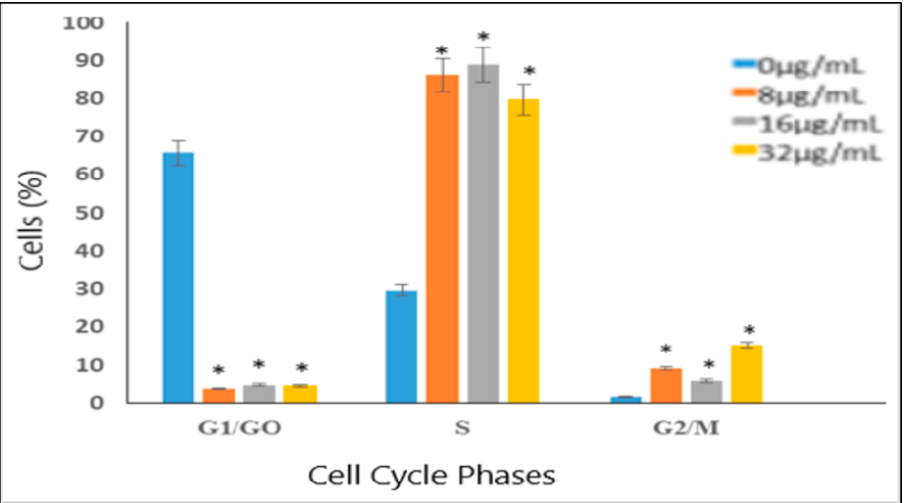
Figure 8. Bar graph showing percentage (%) of OVCAR-3 cells in different phases of the cell cycle. Each point represents the mean ± standard deviation of three independent experiments. * denotes statistically significant difference between the control and the treated group according to ANOVA ( p < 0.05).